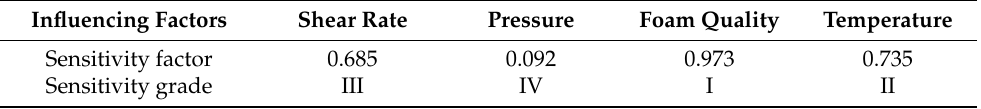
Table 1. Sensitivity factors of influencing